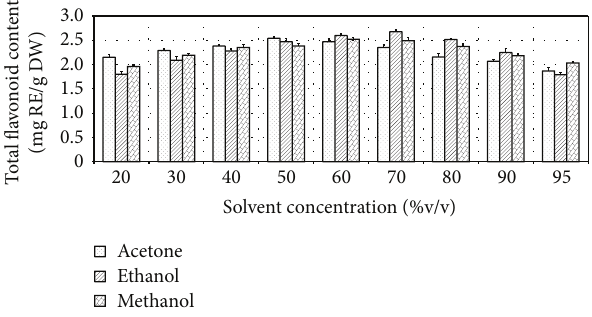
Figure 1: The total content of flavonoids in apple samples, using extractants at various concentrations.